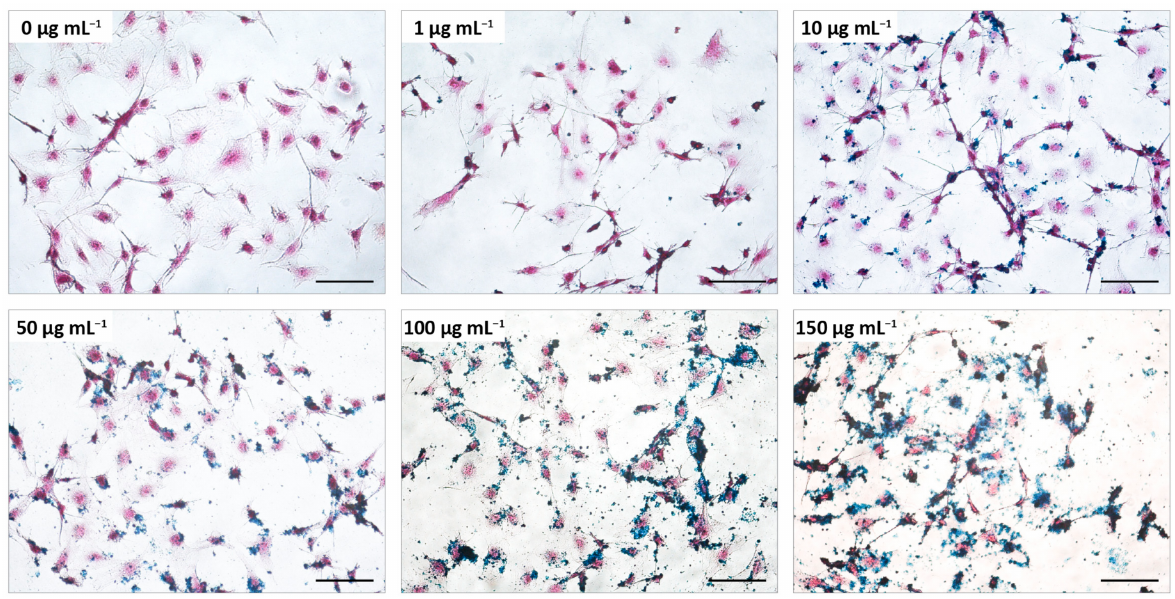
Figure 2. Effect of MAG.PEG on the cell morphology . The vGPCR cells were incubated with dif- ferent concentrations of MAG.PEG (1–150 µ g mL − 1 ) or distilled water as control for 48 h. The cells were stained with H&E and the MNPs were evidenced by the Prussian blue reaction. Represen- tative micrographs from each concentration were obtained by an inverted light field microscope. Scale bar = 100 µ m. Magnification 200 ×